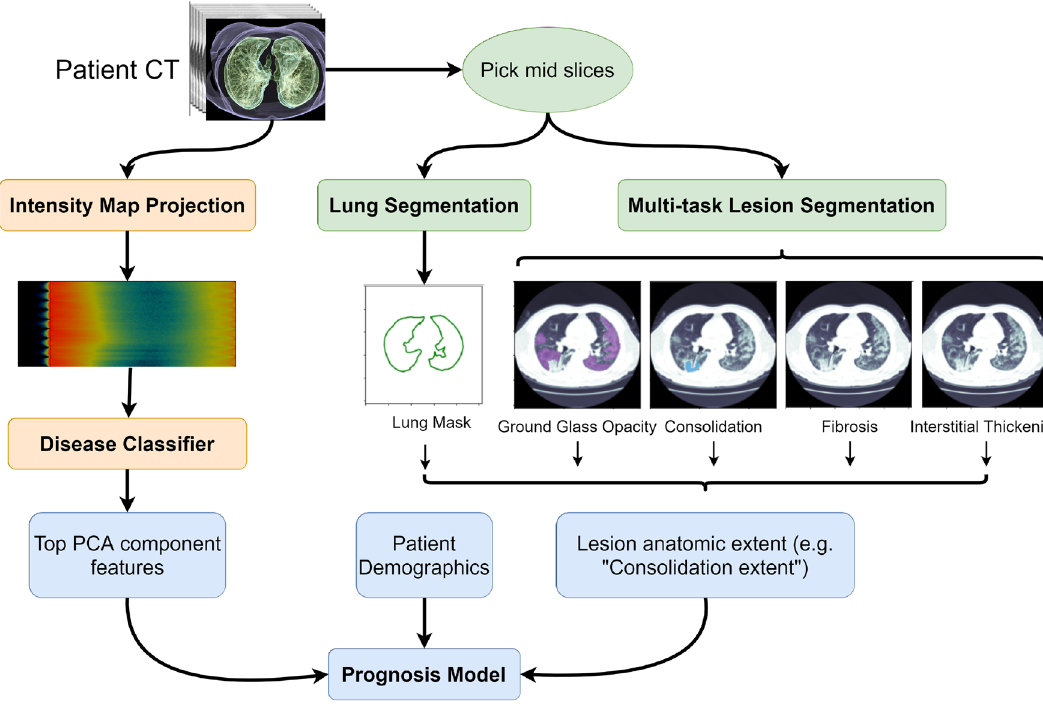
Figure 1. CT-based machine learning pipeline for COVID-19 prognosis. The left side of the figure (orange) represents the intensity map projection and disease classifier presented in the "Methods" section. The right side if the figure (green) shows the use of multitask semantic segmentation to obtain lesion anatomic extent features. Features obtained from the disease classifier, lesion anatomic extent features, and patient’s demographics are then used for mortality prediction using a prognosis model